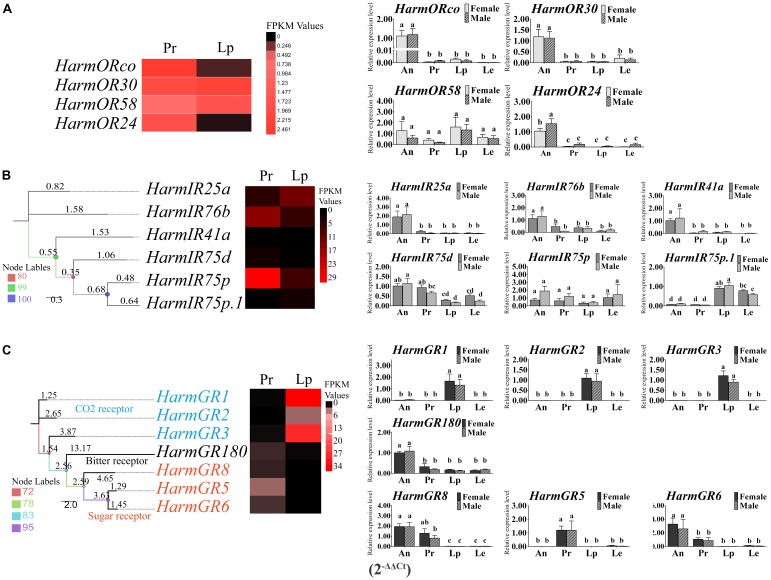
The heat map of the expression level of ORs, IRs, and GRs based on the DEGs analysis and the relative expression level based on the qRT-PCR. The heat maps were generate based on the FPKM values. The column diagrams representing the relative expression level of each gene between four tissues of both sexes were generated based on 2-ΔΔCt. The differences of expression among tissues and sexes were analyzed by one-way ANOVA and followed by Duncan’s test (P < 0.05). Different letters on the top of the columns represent significant difference at P < 0.05. (A) Expression level of ORs; (B) expression level of IRs; (C) expression level of GRs; An, antenna; Pr, proboscis; Lp, labial palps; Le, legs.